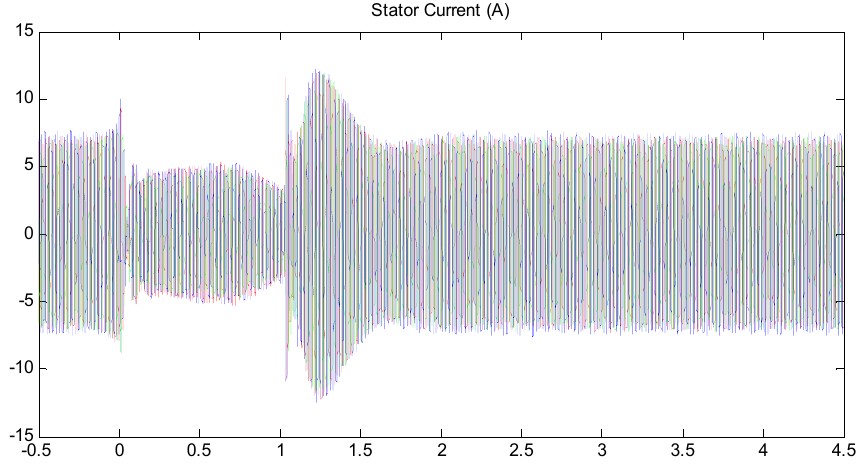
Figure 14. Stator currents, (A) vs. time, (s) during the